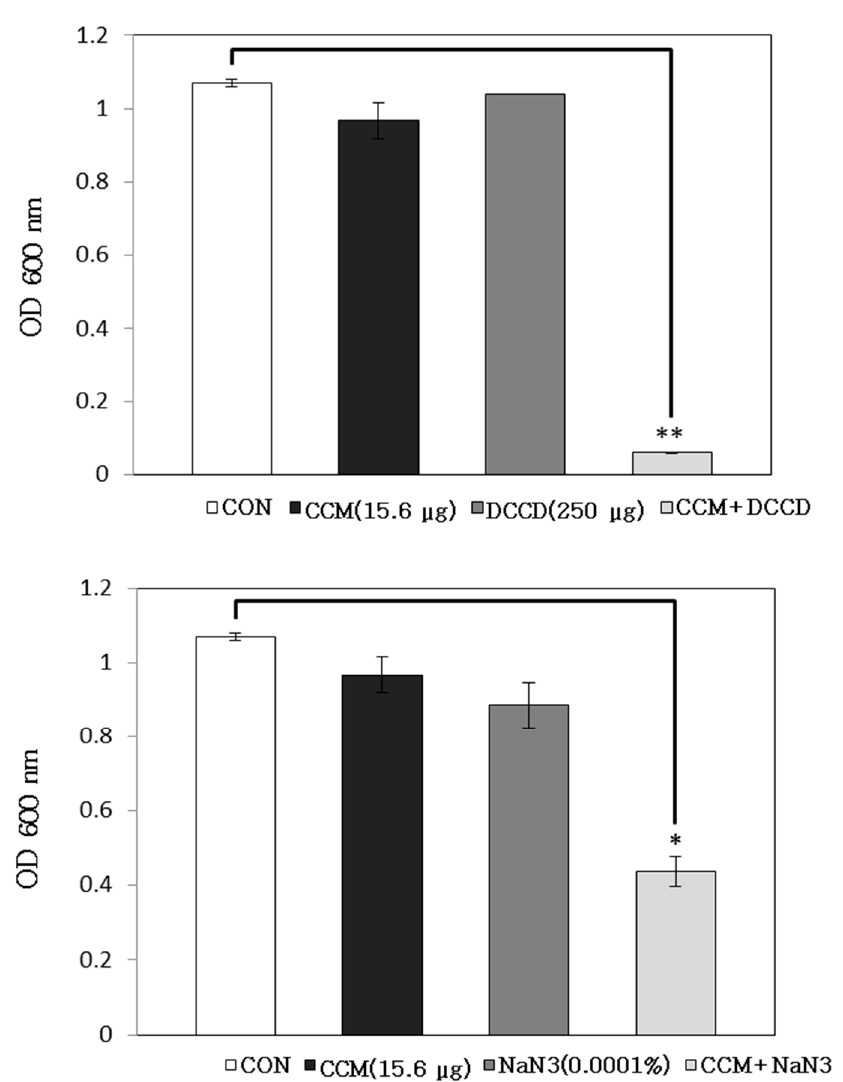
Figure 3. The effects of the ATPase-inhibitors, N,N' -dicyclohexylcarbodiimide (DCCD) and sodium azide (NaN 3 ), on the susceptibility of Staphylococcus aureus (ATCC 33591) to curcumin (CCM) treatment. The viability of bacteria was determined via spectrophotometry (optical density at 600 nm, OD 600 ) after incubation for 24 h with 15.6 μ g/mL CCM with 250 μ g/mL DCCD and 0.0001% NaN 3 , respectively. These data represent the average of three independent experiments. * p < 0.05 and ** p < 0.005, as compared to CCM alone, were determined. CON is the acronym for the control S. aureus strain, which was not